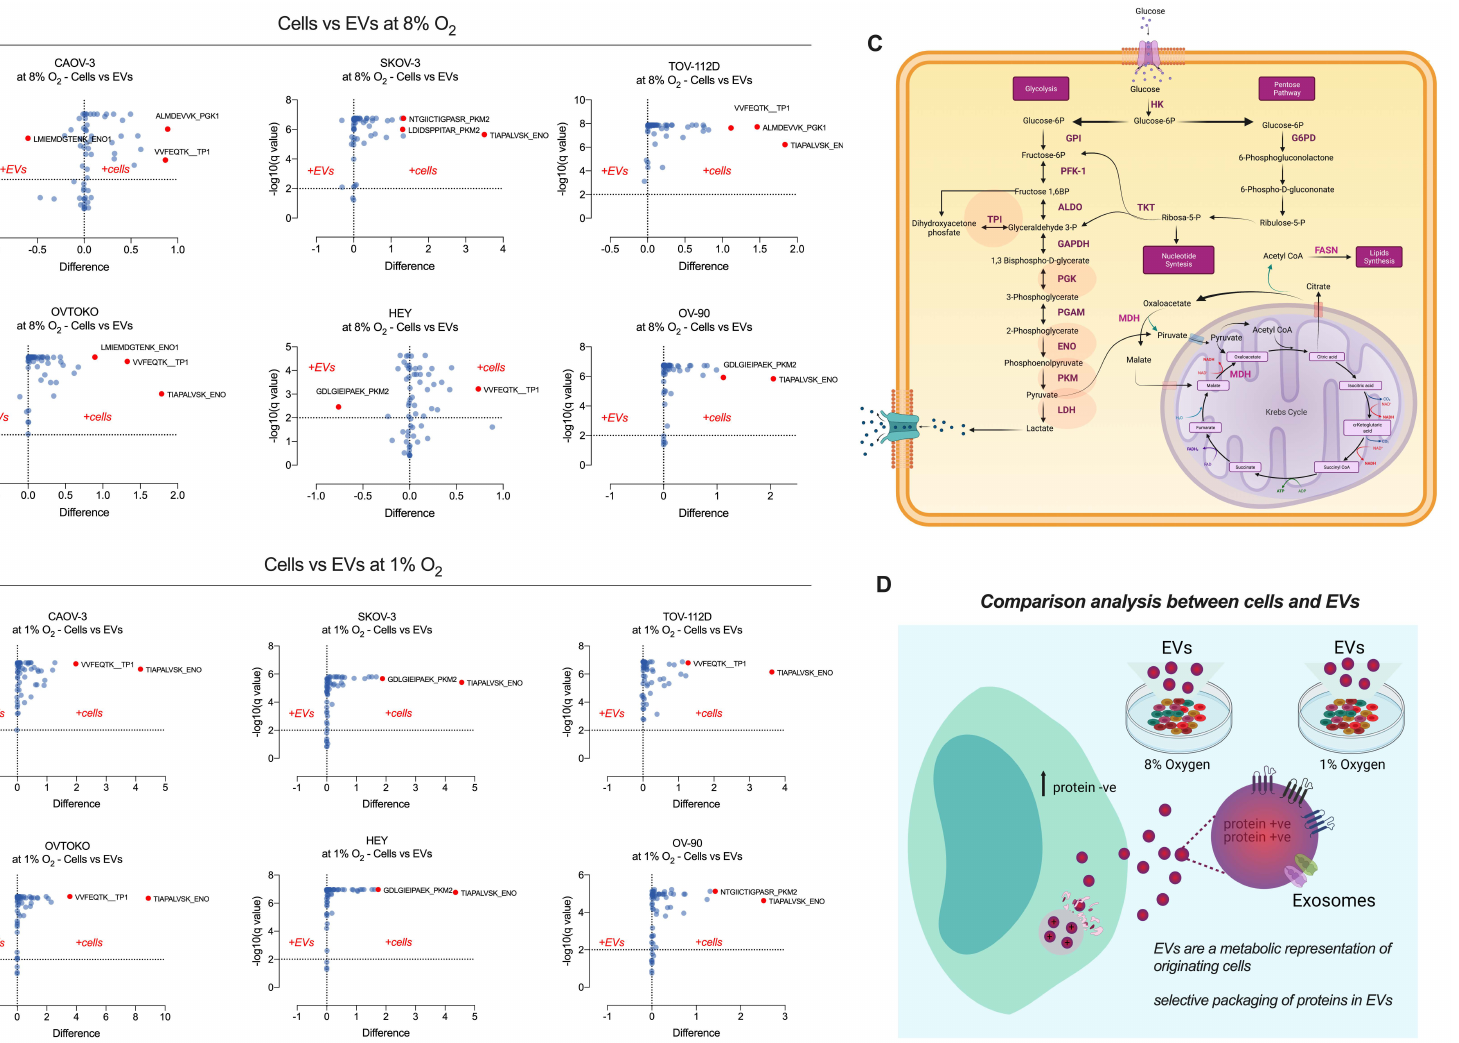
Figure 8. Comparison analysis of the glycolysis proteome in ovarian cancer cells versus their secreted sEVs in response to oxygen tensions. Analysis of the glycolysis proteome in